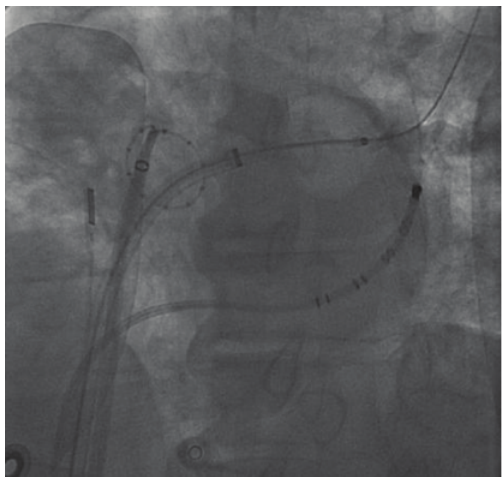
Figure 1: Cryoballoon catheter placement for pulmonary vein iso- lation with fluoroscopic A. Fluoroscopic appearance (30 ◦ left ante- rior oblique view) of the cryoballoon inflated in a left superior pulmonary vein. The guidewire was advanced in a pulmonary vein branch , and the occlusion is confirmed by the absence of flow during contrast injection in the vein. The circular mapping catheter is placed at the ostium of the right superior pulmonary vein. A multipolar catheter in the coronary sinus and an intracardiac echocardiography catheter in the mid-right atrium are visible.